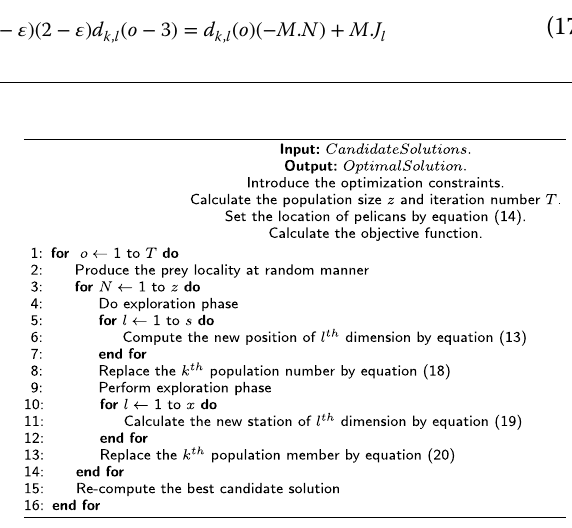
Algorithm 1 FPO Algorithm